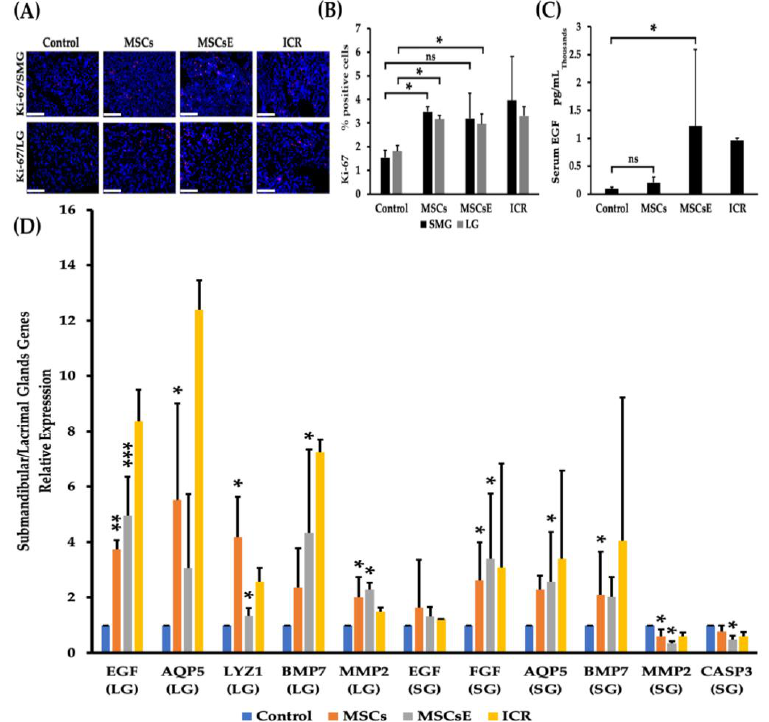
Figure 3. Proliferation rates, serum EGF levels, and gene expression levels of key genes at 16 weeks post-treatment. ( A ) Immunofluorescence staining of submandibular (SMG) (upper panel) and lacrimal (LG) (lower panel) glands for proliferation protein Ki-67 (red), nuclei were stained with DAPI (blue), ( B ) Proliferation rate (Ki-67-positive cells %) for submandibular and lacrimal glands was calculated using random 200 × magnified images (acquired by Volocity software) using Image J software. Two examiners independently analyzed images in a blind manner. MSCs / MSCsE treatments promoted tissue proliferation in the glands significantly higher than the control group and their rates were comparable to the ICR group. ( C ) Serum levels of EGF measured by ELISA. Both treatments elevated EGF levels in comparison to the control group, but only MSCsE treatment induced a significantly higher level. ( D ) Relative expression of key genes for tissue function, repair, regeneration, and apoptosis were